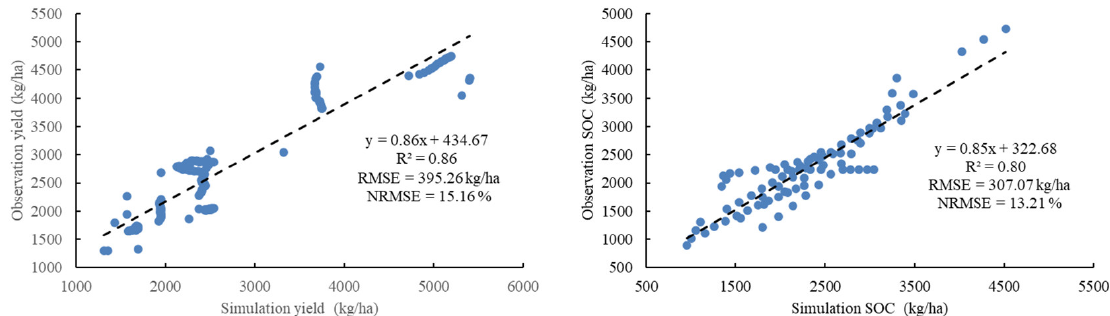
Figure 3. DNDC simulation accuracy for wheat yield and SOC between 1990–2000 for 19 sites in Australia.